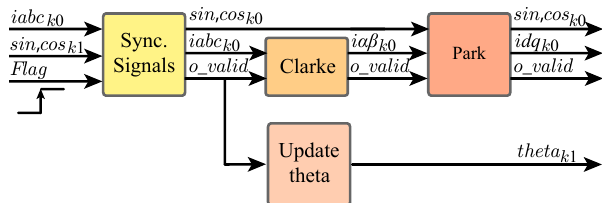
Figure 4. Block diagram of the hardware design for transformation block (dq